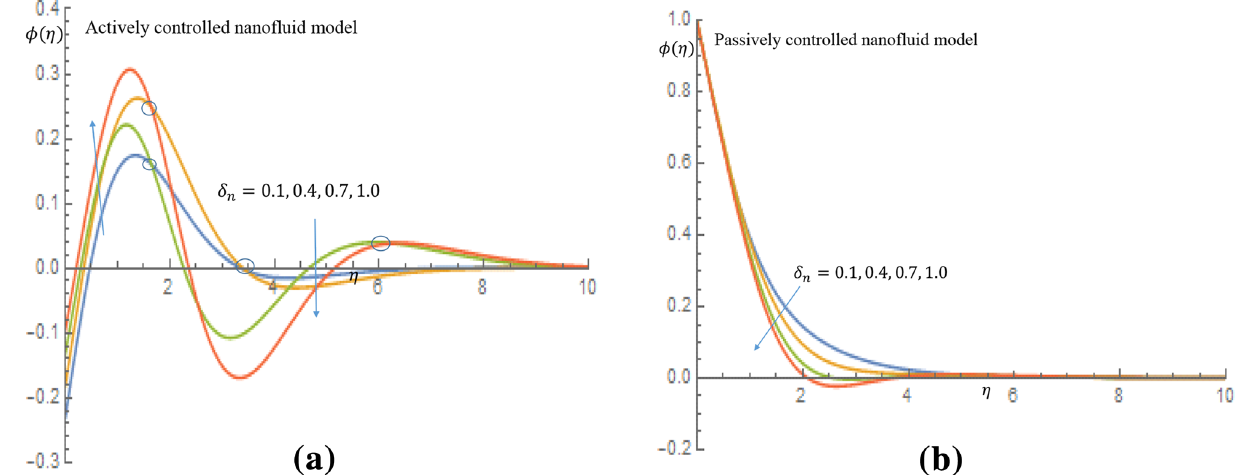
Figure 11. ( a ) Effect of δ n on nanoparticles concentration profile when K 1 = K 2 = 1.2 . ( b ) Effect of δ n on nanoparticles concentration profile when K 1 = K 2 = 1.2 .